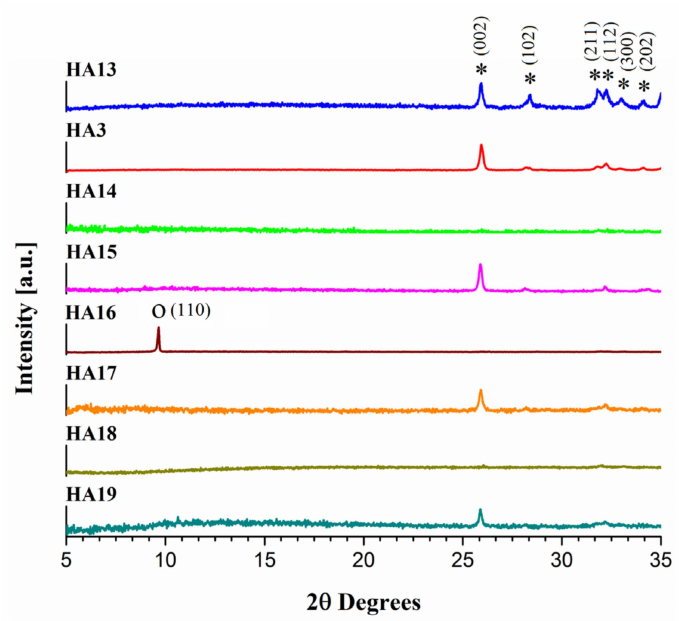
Figure 7. XRD patterns of the samples HA13, HA3, and HA14–HA19. Peaks marked with * belong to HA and the peak marked with O belong to OCP. ICDD file for HA: 01-084-1998 and ICDD file for OCP: